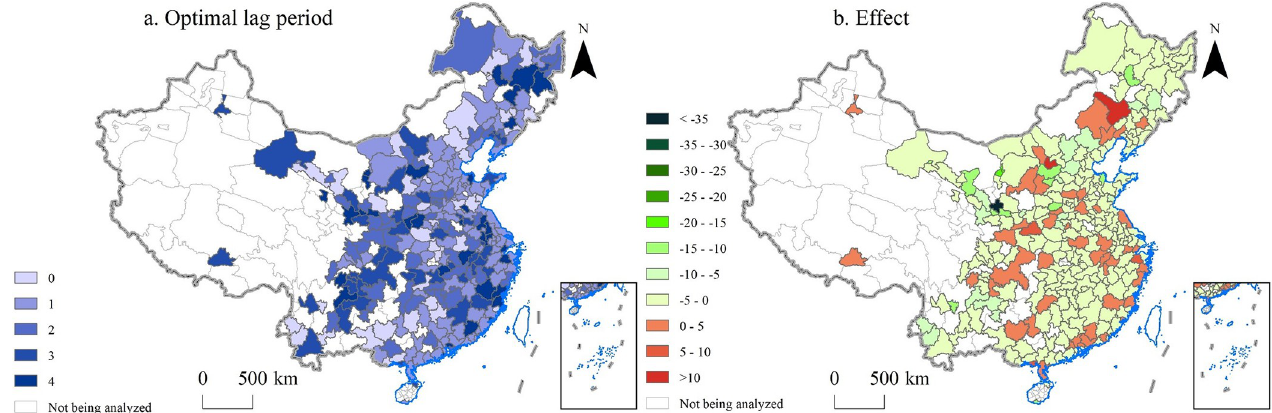
Fig 7. The optimal lag period and effect of average export similarity index (AESI) on commodity concentration index (CCI). The optimal lag period is the lag period with the minimum mean standard error. Meaning of effect: If AESI is increased by one unit, CCI will increase/decrease by the corresponding amount. CCI’s increases are expressed as positive values and decreases as negative values.